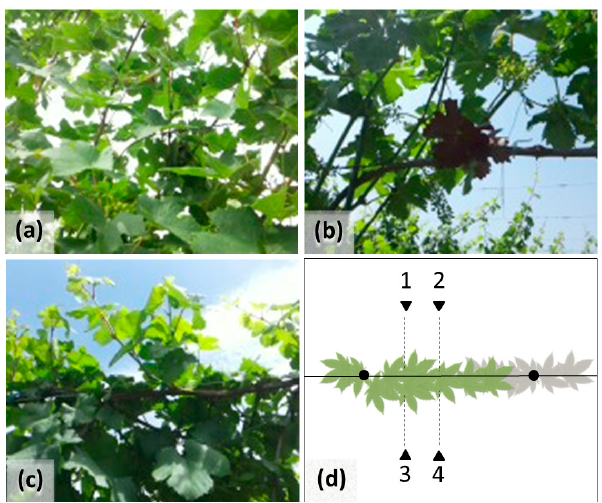
Figure 1. Example of correct image captured with PocketLAI following the protocol ( a ); and wrong images that include the space below ( b ) or above ( c ) the vertical trained canopy of Vitis vinifera. Protocols for LAI data acquisition ( d ): dark triangles and dotted lines = device orientation; black points vineyard poles; continuous line = vineyard row; green leaves = measured vine; grey leaves = adjacent vine.